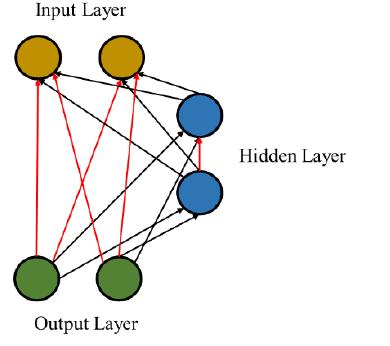
Figure 2. Cascade forward back propagation network.